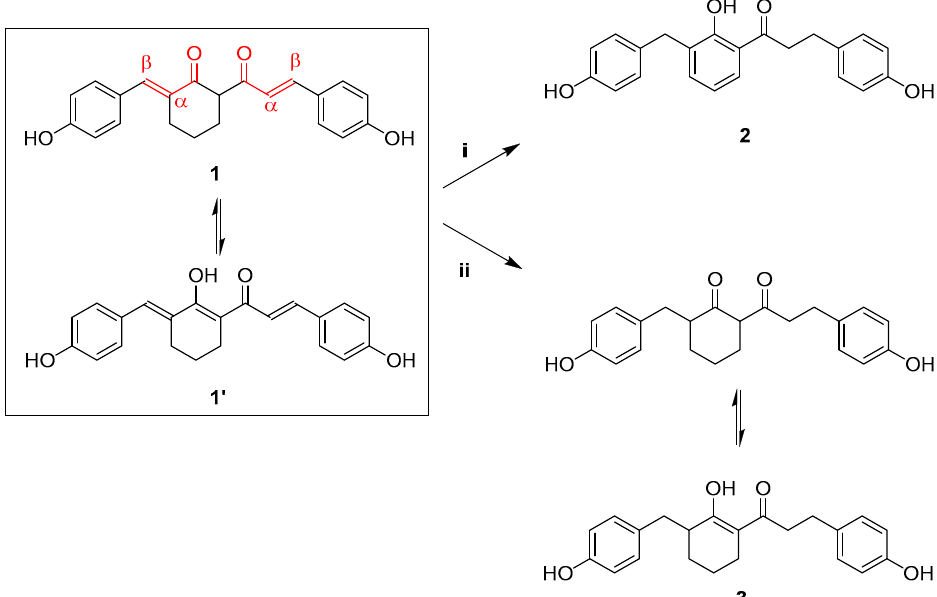
Figure 1. Removal of enone functionalities in cyclohexanone derivative 1 through disproportionation to phenol 2 or catalytic transfer hydrogenation to reduced 1,3-diketone 3 . Reagents and conditions: (i) 10% Pd-on-C, d -limonene, 0 ◦ C, then 180 ◦ C, 3 h, 64%; (ii) 10% Pd-on-C, cyclohexene, methanol, 65 °C, 2 h, 15%.